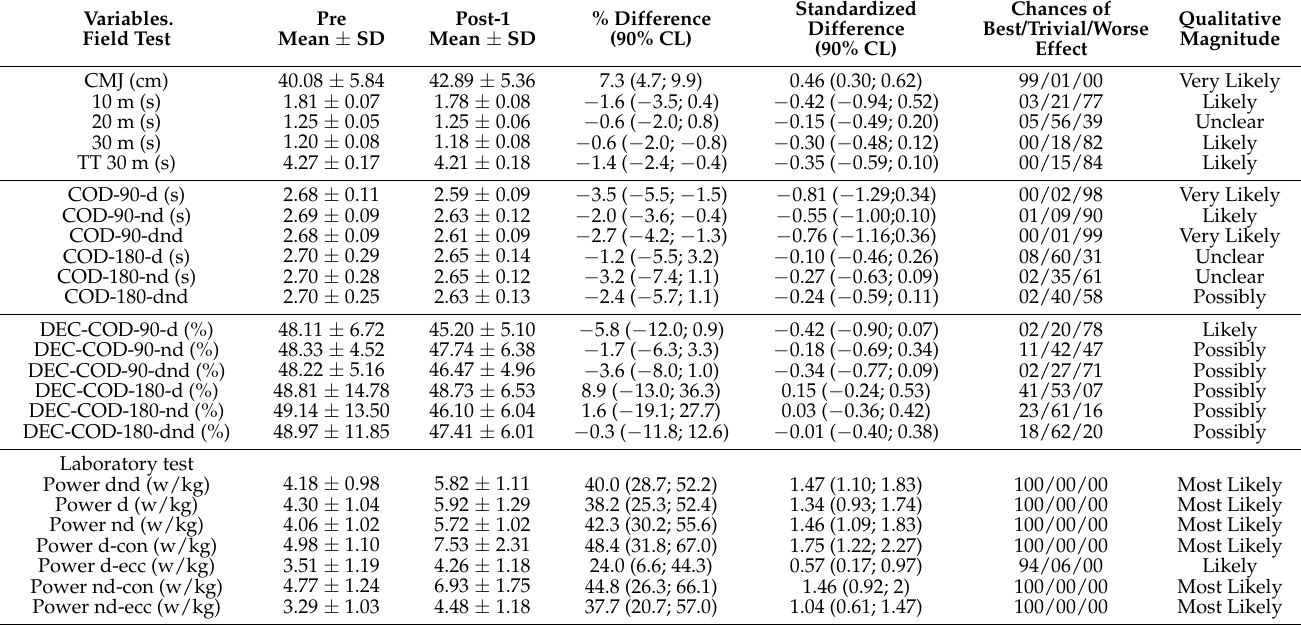
Table 1. Changes in performance after the first three-week period (pre- to post-1) of flywheel